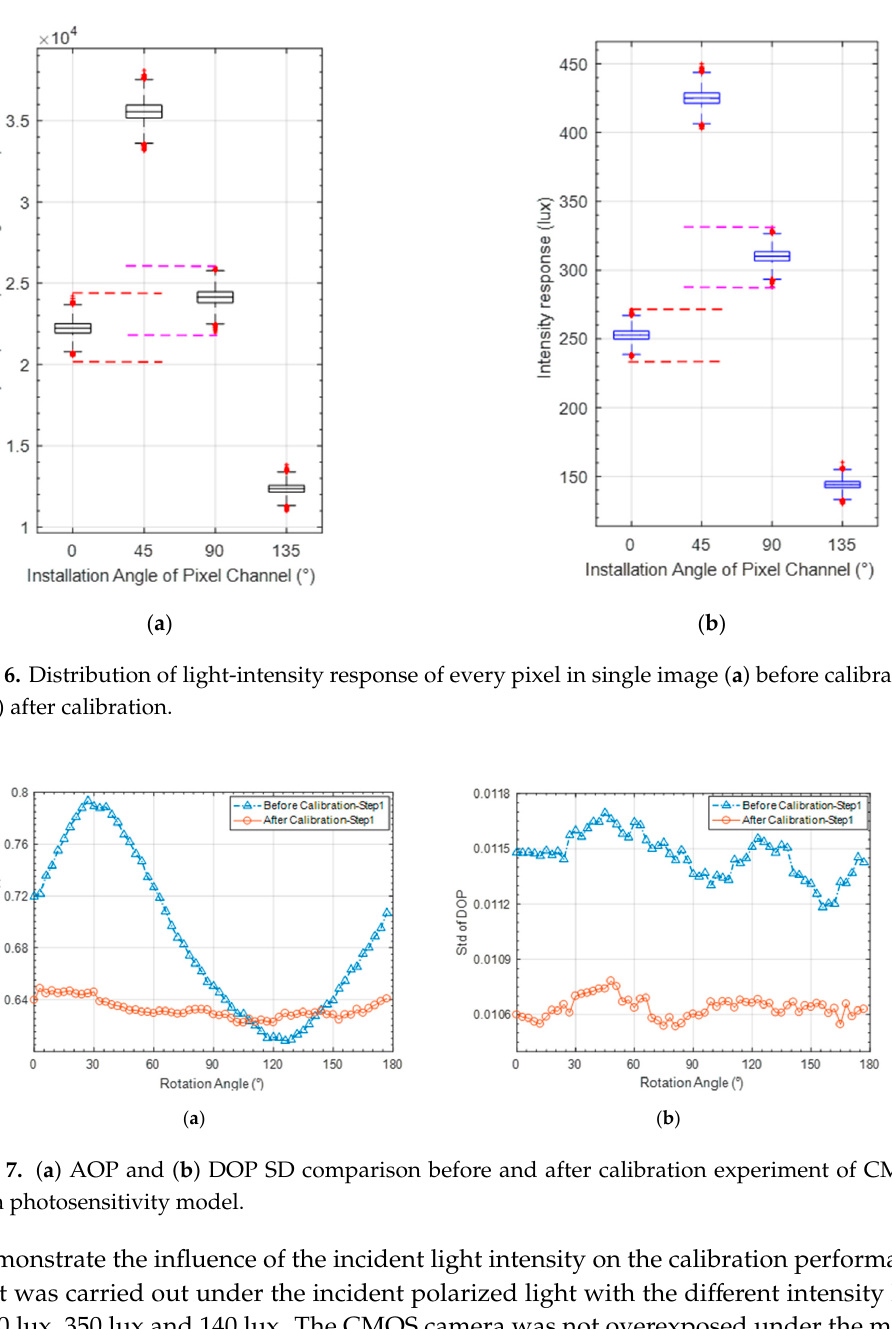
Figure 7. ( a ) AOP and ( b ) DOP SD comparison before and after calibration experiment of CMOS camera photosensitivity model.